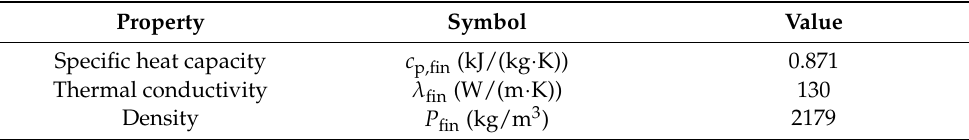
Table 2. Thermo-physical properties of aluminum